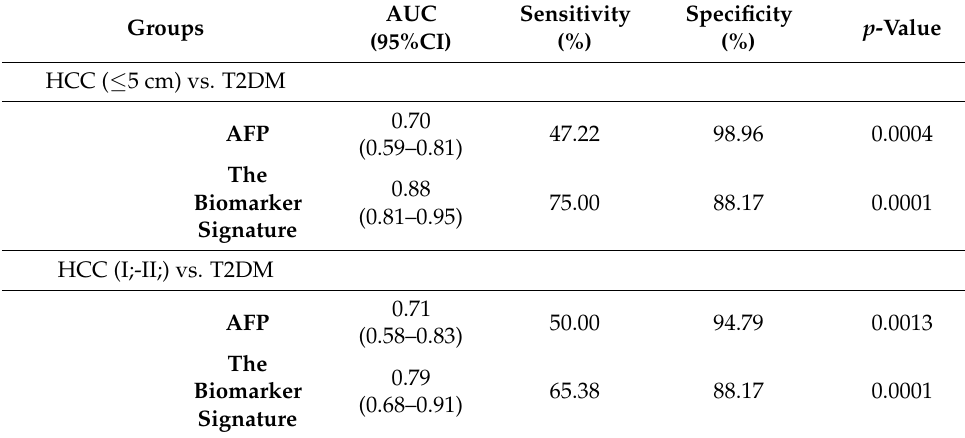
Table 5. The diagnostic performance of the biomarker signature for the detection of small-size and early-stage T2DM(+)